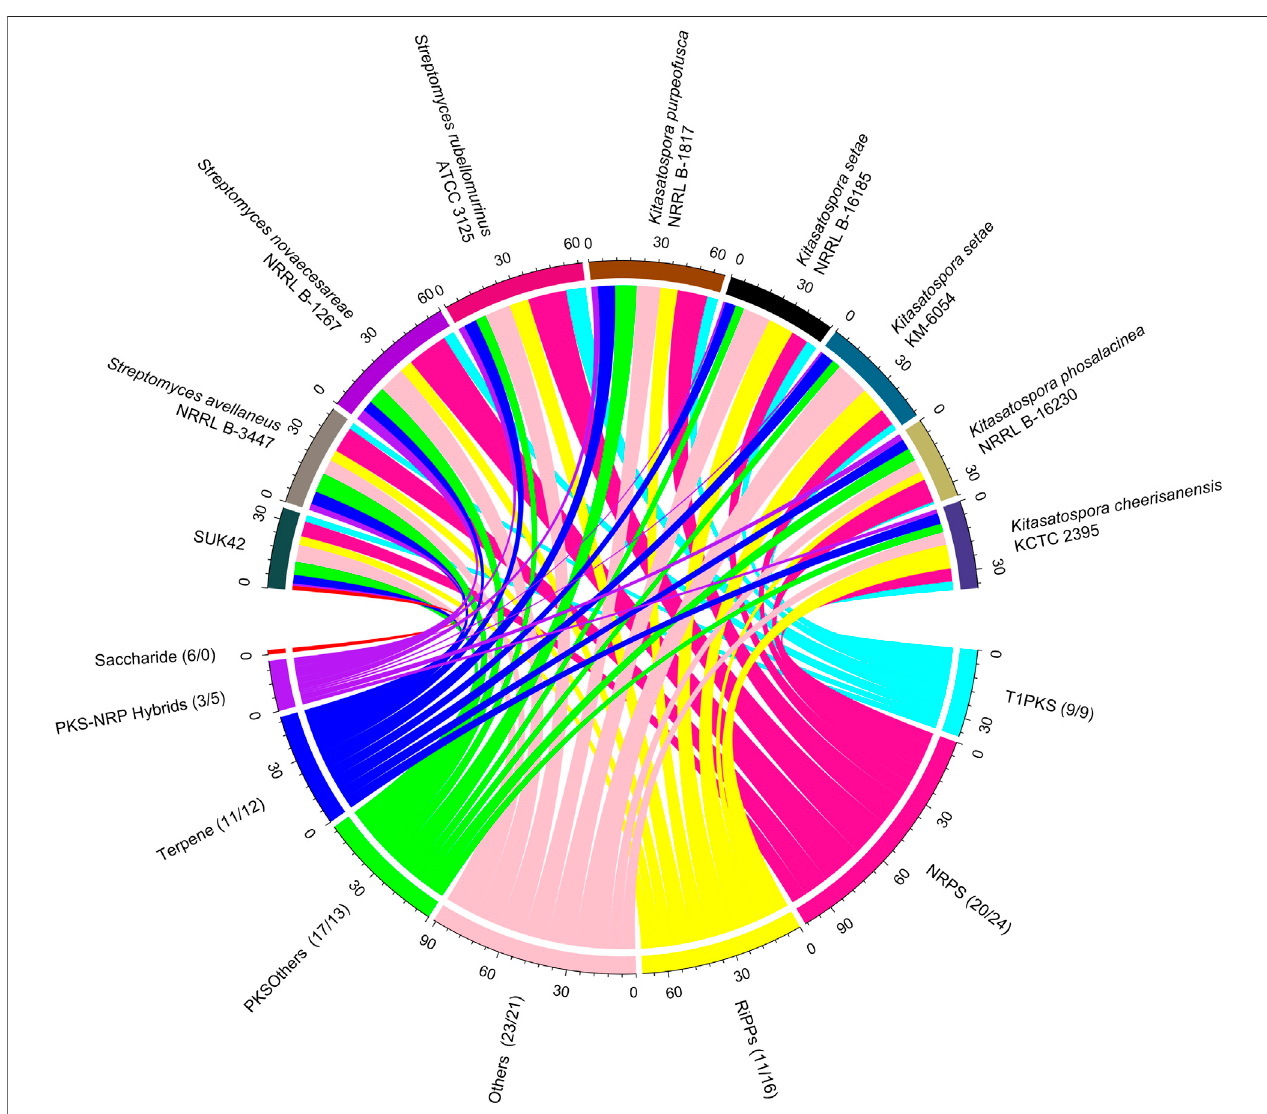
FIGURE 6 | SUK42 is the only member of Kitasatospora reference sequences to encode Saccharide-type BGCs. Chord diagram illustrating the distribution of Gene Cluster Families amongst SUK42 and related strains. Of the eight, Kitasatospora sequences was the only one to encode Saccharide type clusters. Values in brackets are the percentage of clusters in a GCF that belong to SUK42 or the eight reference sequences, respectively. Gene clusters were fi rst identi fi ed using AntiSMASH (Blin et al., 2019) before assigned to individual families using BIG-SCAPE (Navarro-Munoz et al., 2020). Plotted using the circlize package in R.